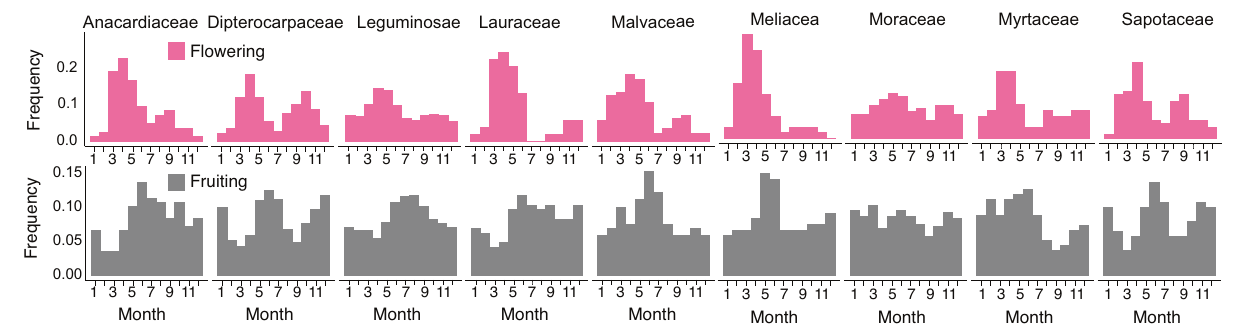
Fig. 3 Seasonal trends in fl owering and fruiting phenology. Histograms of fl owering (pink) and fruiting (gray) frequencies were drawn for nine families in which at least fi ve species were included. The number of species included for each family is given in Fig. 1a.